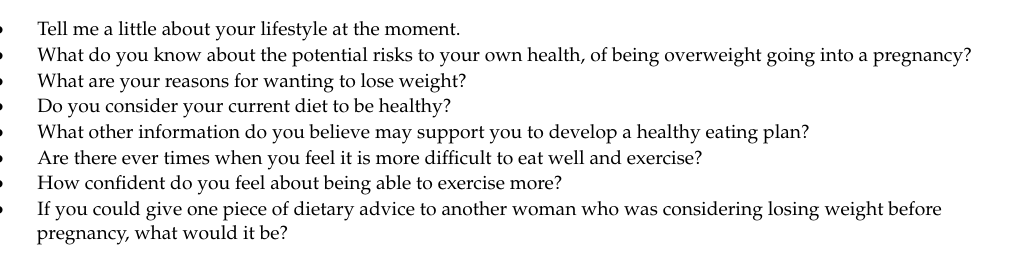
Table 1. Indicative semi-structured interview